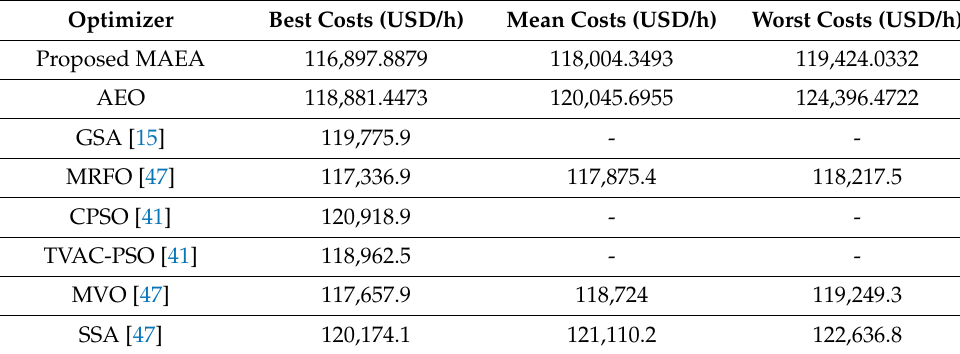
Table 8. Comparative Results for Case 3 for the 48-Unit System.